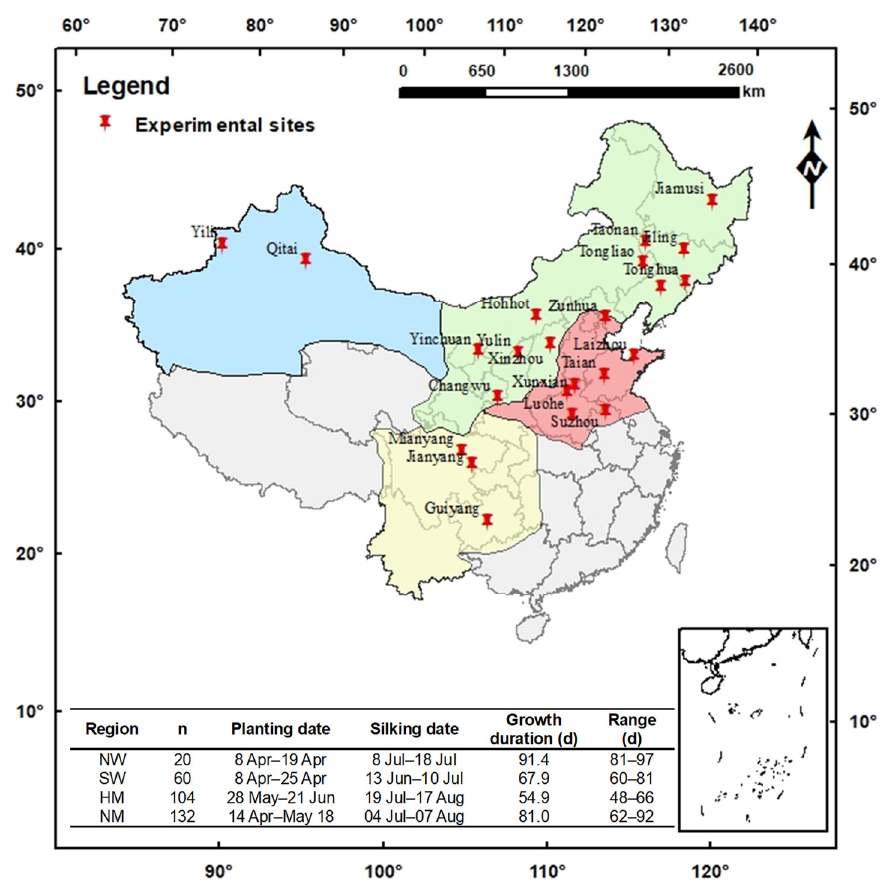
Figure 1. The spatial distribution of the experimental sites and the locations of the northwestern maize region (NW), northern spring maize region (NM), Huanghuaihai maize region (HM), and the southwestern maize region (SW) in China, as well as maize growth information during the vegetative growth stage. n means number of data samples.